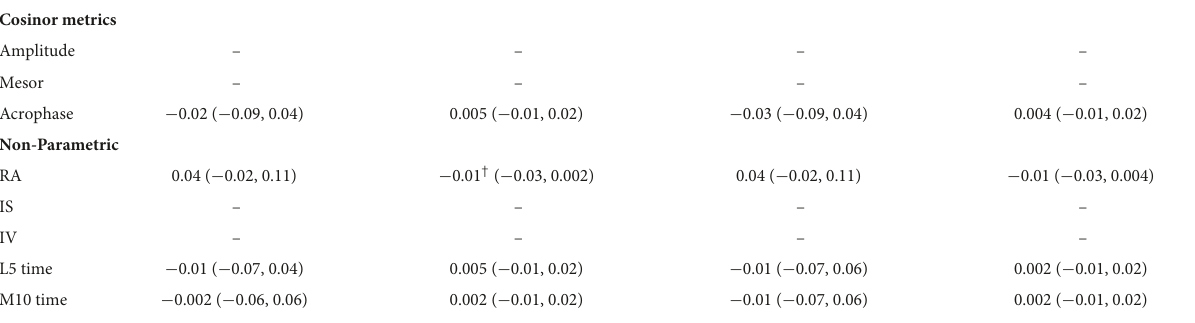
TABLE 9 Associations of circadian metrics with visuospatial ability, estimated beta (95%